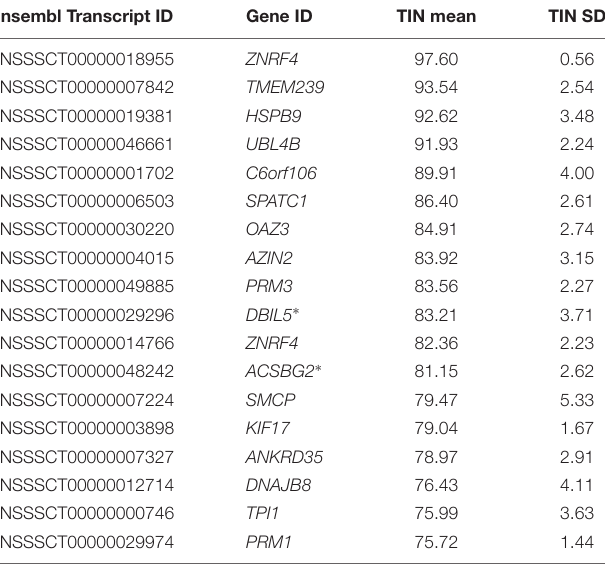
TABLE 2 | List of the 10% most abundant intact transcripts (TIN > 75) in the boar